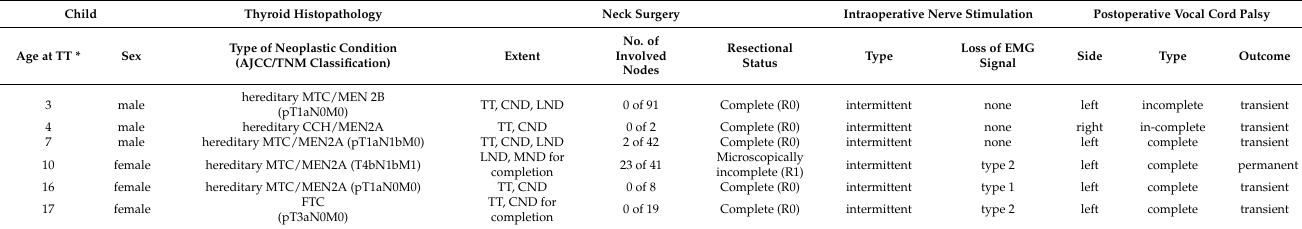
Table 4. Children with normal preoperative nerve function and early postoperative vocal cord